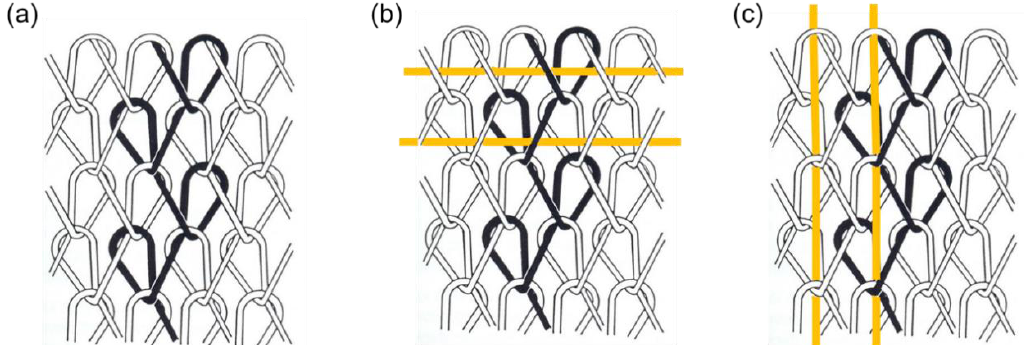
Figure 12. Warp-knitted structure and fiber optic application: ( a ) warp-knitted structure; ( b ) and ( c ) optical fibers laid in warp-knitted structure.